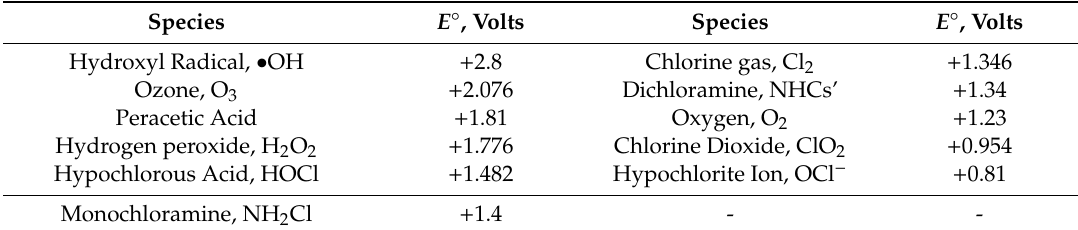
Table 3. Oxidizing compounds and their respective reduction potentials. Used with permission of the Engineers’ Society of Western Pennsylvania. Species E ◦ , Volts Species E ◦ ,